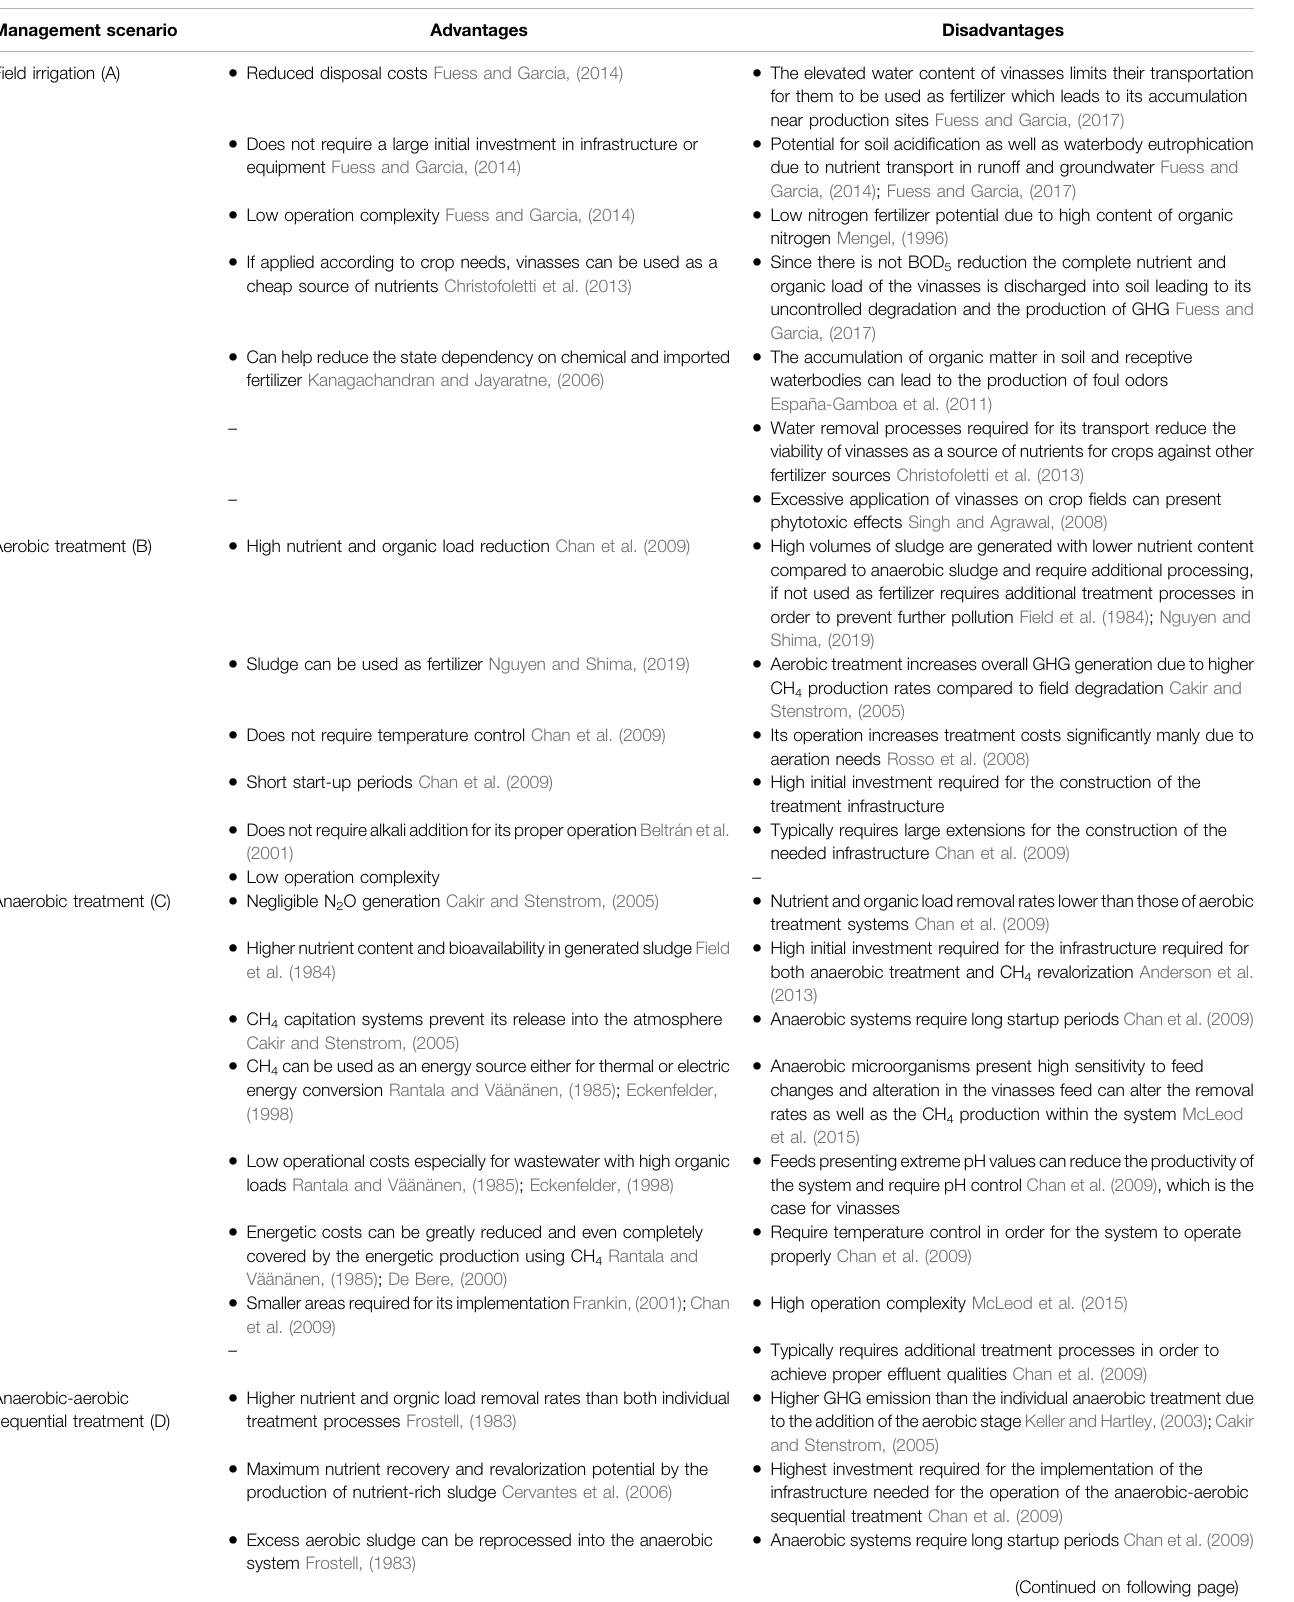
TABLE 10 | Comparison between the advantages and disadvantages of the proposed vinasses management scenarios. Management